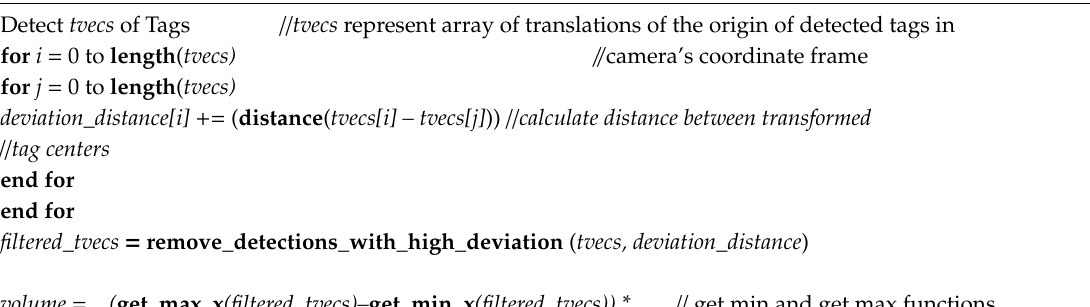
Algorithm 2. Calculating the Error in the Net Pose Estimation of the 3D Grid Board. Detect tvecs of Tags